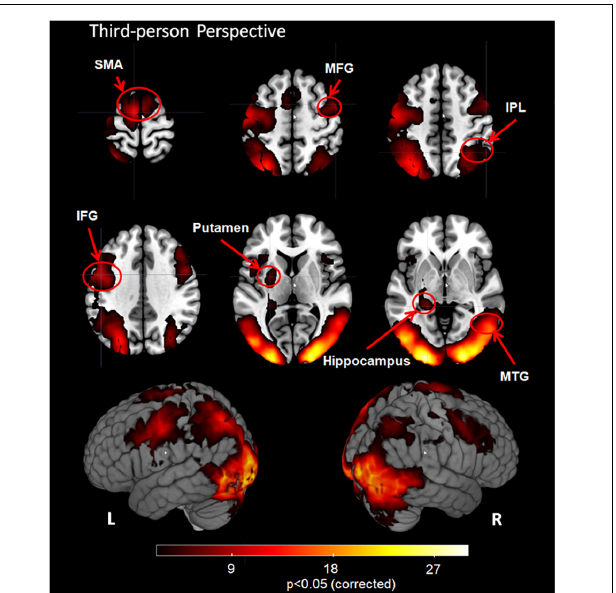
FIGURE 2 | Group analysis results for action observation and understanding from the first-person perspective with a Z-statistic threshold of 2.3 and corrected cluster P < 0.05. SMA: supplementary motor area; MFG, middle frontal gyrus; IPL, inferior parietal lobule; IFG, inferior frontal gyrus; MTG, middle temporal gyrus; L, left hemisphere; R, right hemisphere.